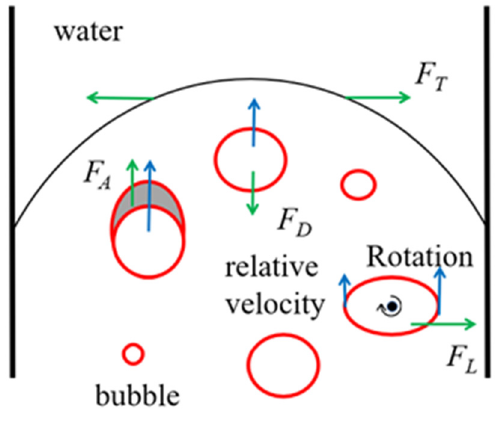
Figure 1. Interphase forces of gas–liquid flow in a multiphase pump [27] .